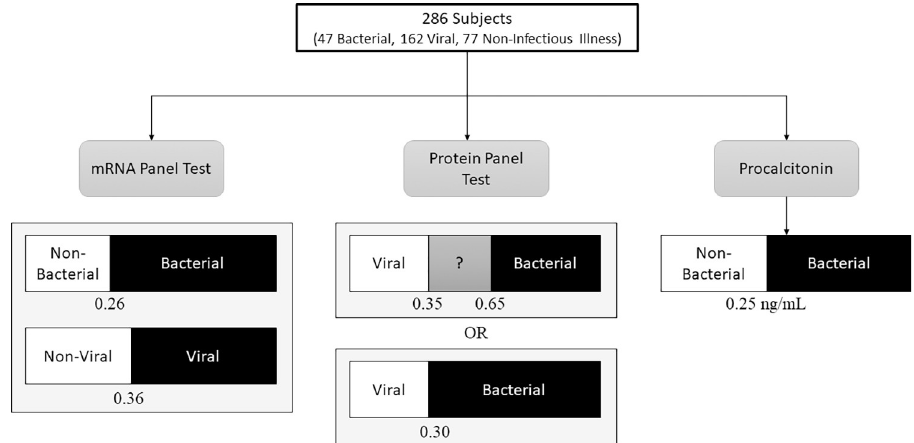
Fig 1. Study schematic. The analysis cohort included 286 subjects, each of which had three bacterial vs. viral biomarkers measured. The mRNA panel results were based on a previously published study using the BioFire system to measure 45 host response transcripts. This test reports independent results for bacterial vs. non-bacterial (viral or non-infectious illness) and viral vs. non-viral (bacterial or non-infectious illness), each with its own threshold. The protein panel test measures IP-10, TRAIL, and CRP. Two sets of thresholds were applied. The first, based on published values, assigns values below 0.35 as Viral, values above 0.65 as Bacterial, and values from 0.35–0.65 as equivocal. A second scheme was utilized whereby a single optimized threshold of 0.30 was used to distinguish bacterial from viral infections. The third biomarker, procalcitonin, used the established threshold of 0.25 ng/ml to distinguish bacterial from non-bacterial